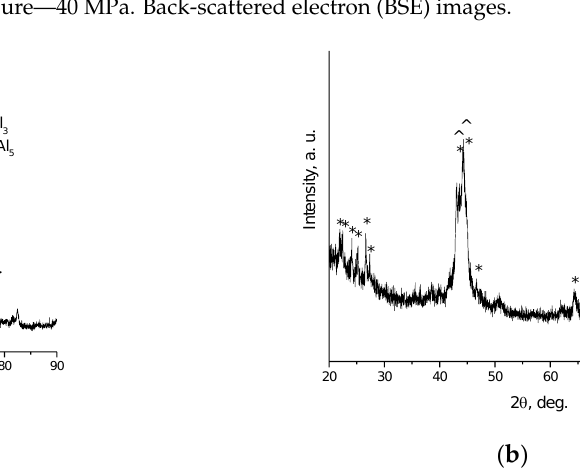
Figure 1. Microstructure of the composites obtained by spark plasma sintering (SPS) of Al – 20 vol.% Fe 66 Cr 10 Nb 5 B 19 ( a ) and Al – 50 vol.% Fe 66 Cr 10 Nb 5 B 19 ( b ) mixtures. The shell of a particle at a higher magnification ( c ). Al powder 3 – 10 μm. SPS conditions: temperature — 570 °C, holding time — 3 min, applied pressure — 40 MPa. Back-scattered electron (BSE) images.